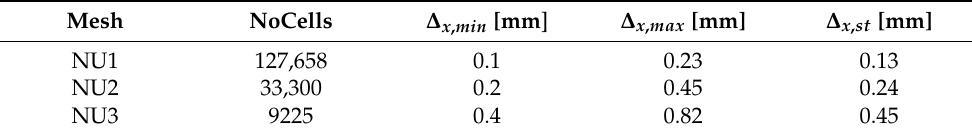
Table 1. Numerical grid parameters. ∆ x , st is the average cell size at the stoichiometric condition throughout the domain ∆ x , st = (cid:104) ∆ x | Z = Z st ± 0.01 (cid:105) . Mesh NoCells ∆ x , min [mm ] ∆ x , max [mm] ∆ x , st [mm] NU1 127,658